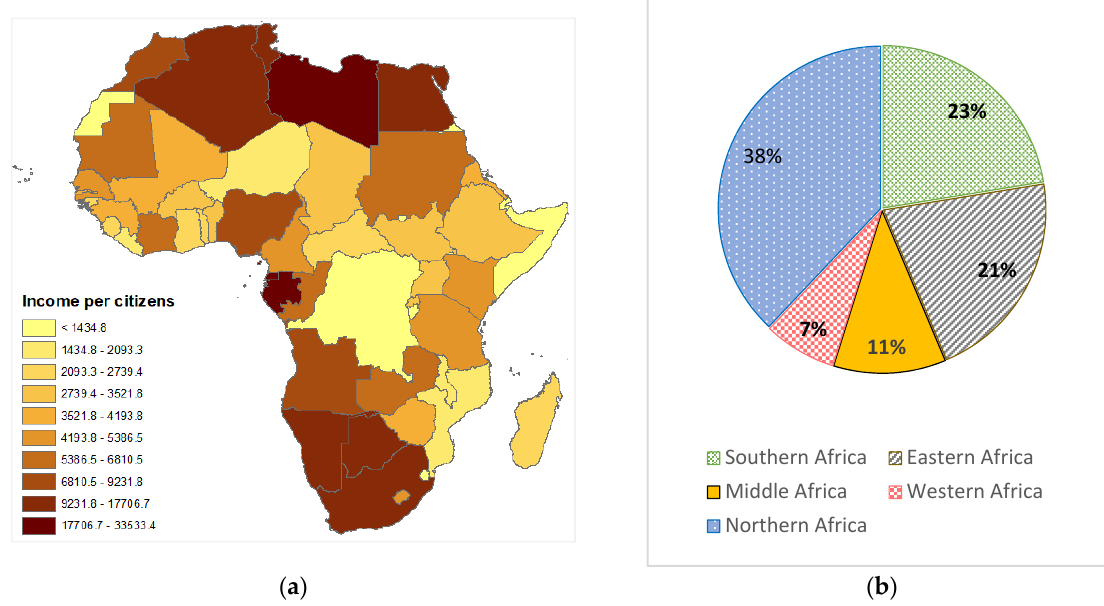
Figure 4. Average income (PPP) per citizens in USD* from 1990–2019 ( a ) for all African countries, ( b ) proportion on regional basis. * The income per citizen was in “inflation-adjusted dollars” based on 2010. The reason for choosing 2010 is explained in the material and method. Sources: Authors’ compilation, analysis and mapping from WID, WB, and WDI databases.